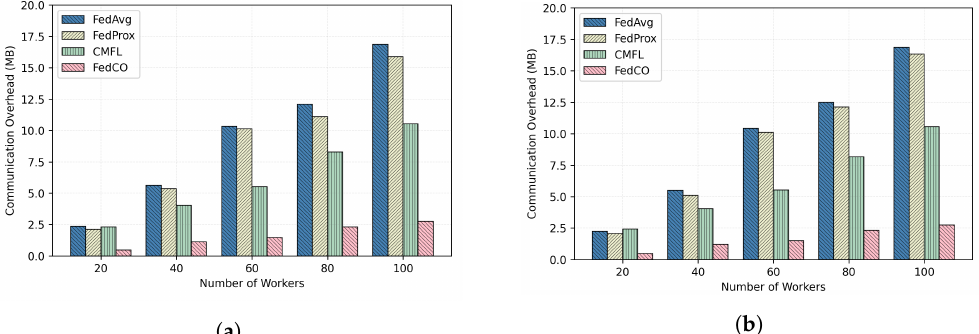
Figure 11. The communication overhead for 100 rounds for the MNIST data. The top plot presents the results produced in the case of the IID data distribution scenario, while the bottom plot depicts the results generated in the case of the Non-IID data distribution scenario. ( a ) IID. ( b )